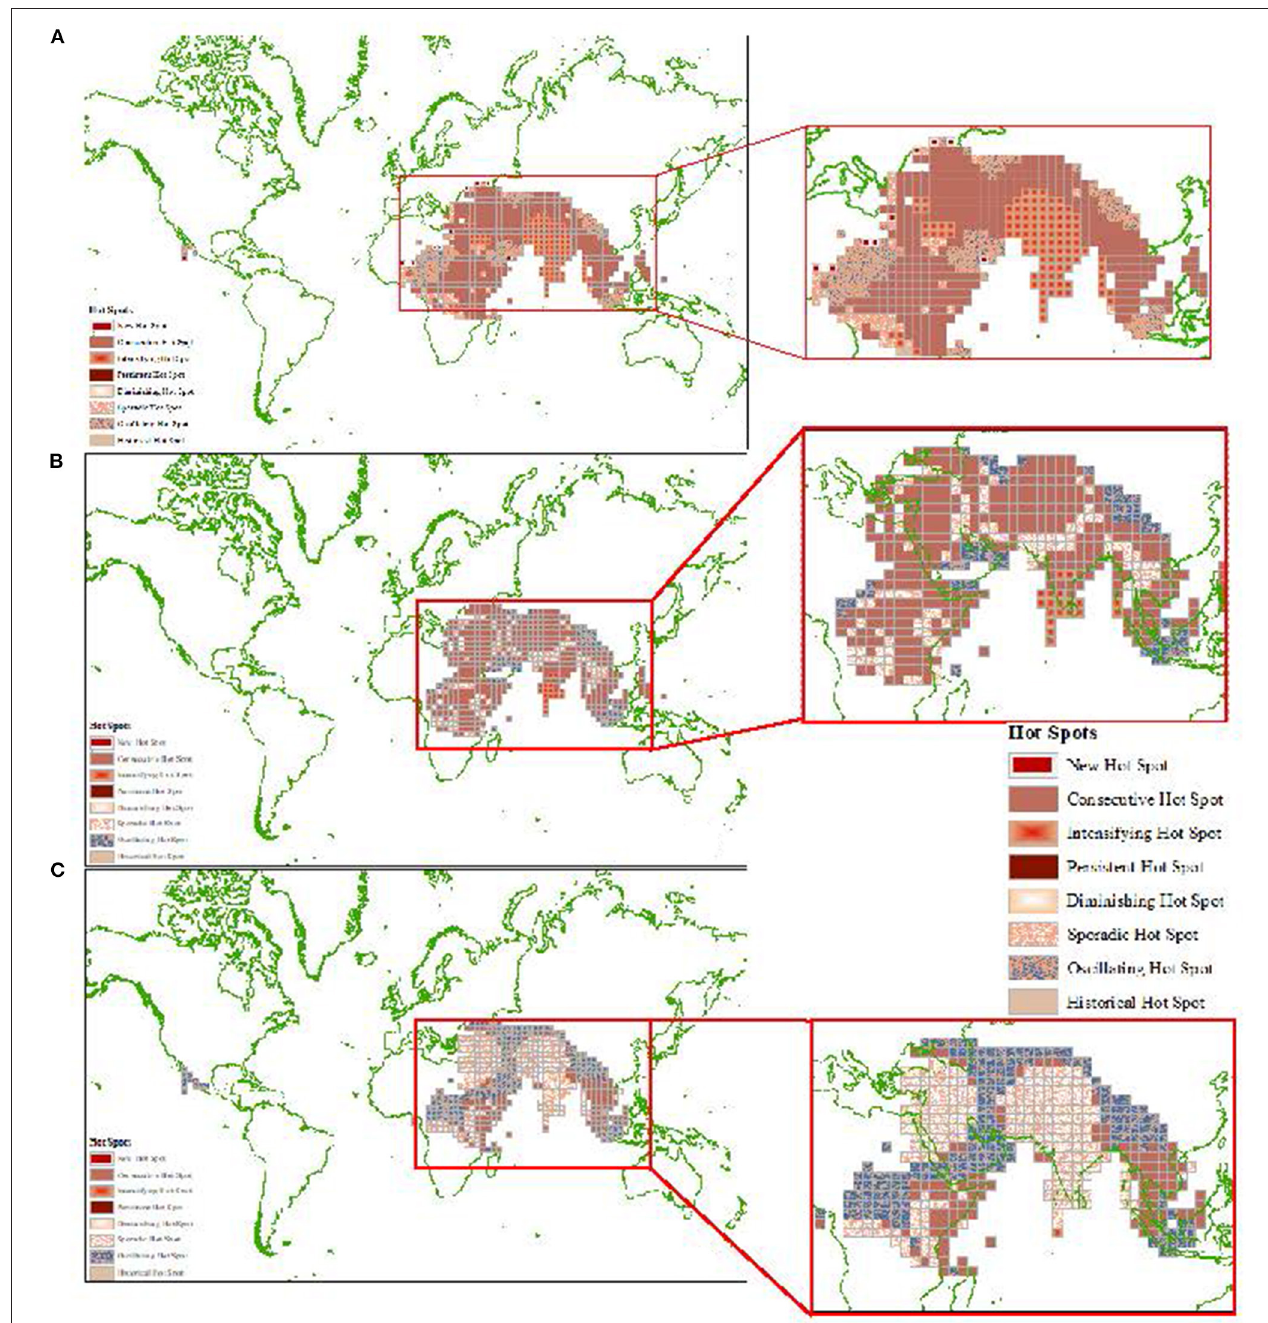
FIGURE 4 | Results of emerging hot spots analysis of the spatial patterns of conflicts during 1989–2014 (A) All years; (B) El Niño years; (C) La Niña years.